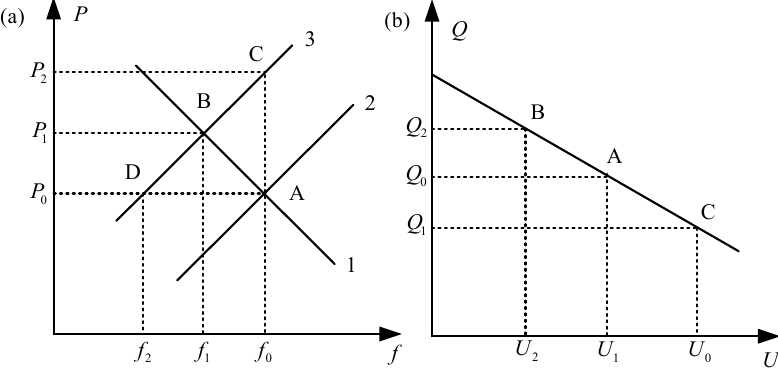
Figure 1. Control circuit diagram of current-controlled virtual synchronizer system.